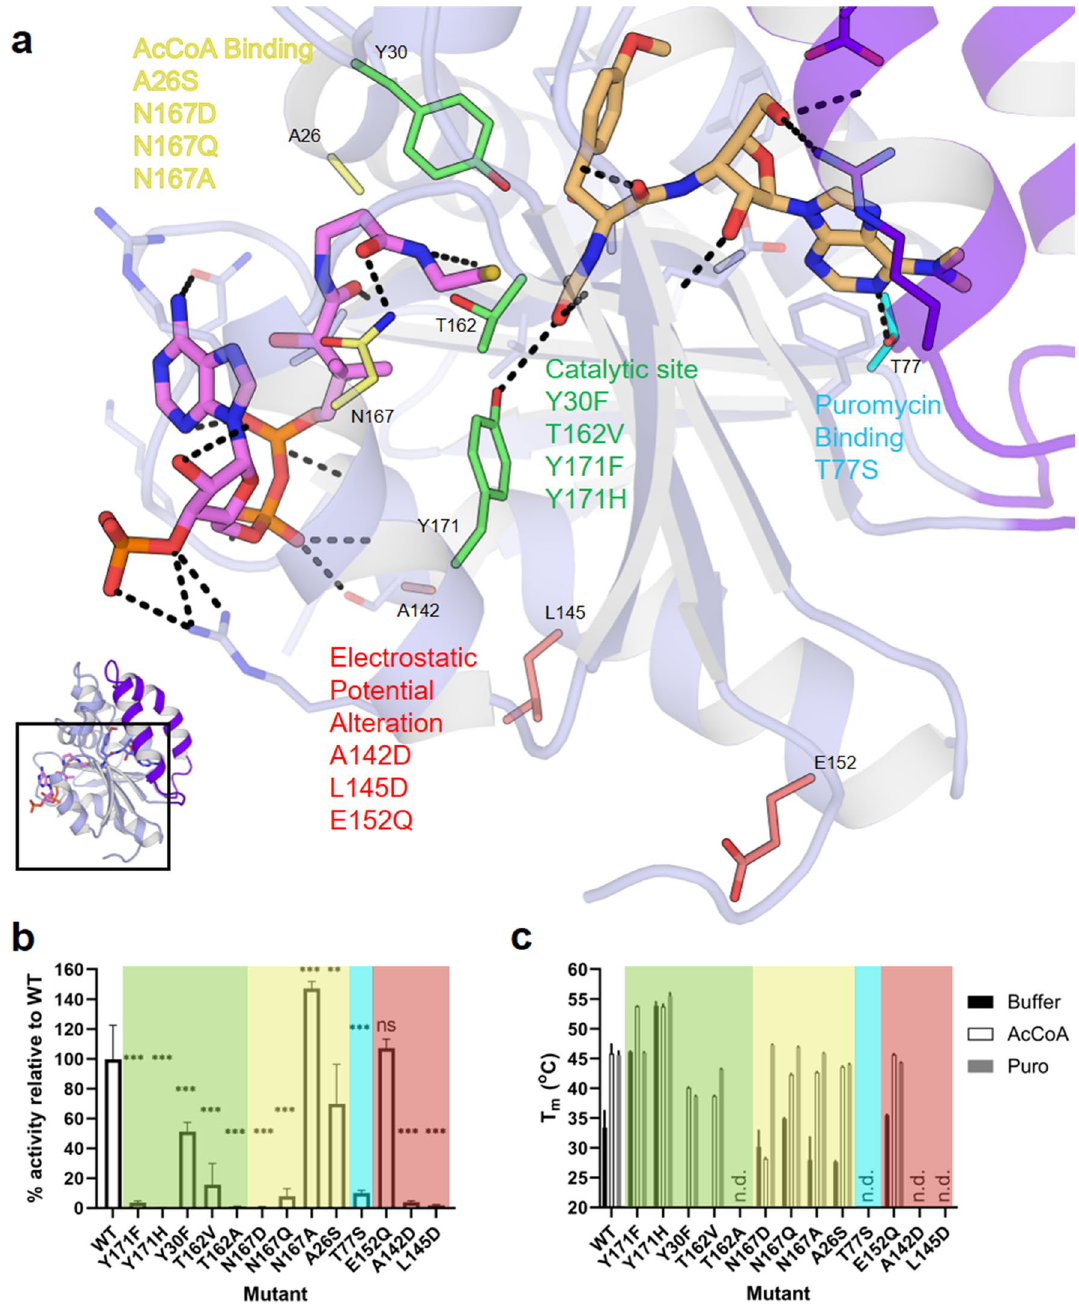
Figure 2. Structure-based enzyme engineering of PAC. ( a ) A network of molecular interactions between the PAC sidechains and (Ac)CoA (pink) and (acetylated-)puromycin (orange) identified for mutagenesis based on their role in substrate binding and catalysis. ( b ) Relative enzyme activities of PAC mutants under steady-state conditions normalised to protein concentration. Numerical values can be found in Supplemental Table S2. Comparisons in activity measurements are using a one-way ANOVA analysis: ***p < 0.001, **p < 0.01. “ns” not significant. ( c ) Differential scanning fluorimetry derived melting temperatures (T m ) of PAC mutants in purification buffer with or without the addition of either 0.2 mM AcCoA or 0.2 mM puromycin. Numerical values can be found in Supplementary Table S3. Error bars indicate standard deviations from at least three repetitions. “n.d.” indicates melting curves that showed no measurable